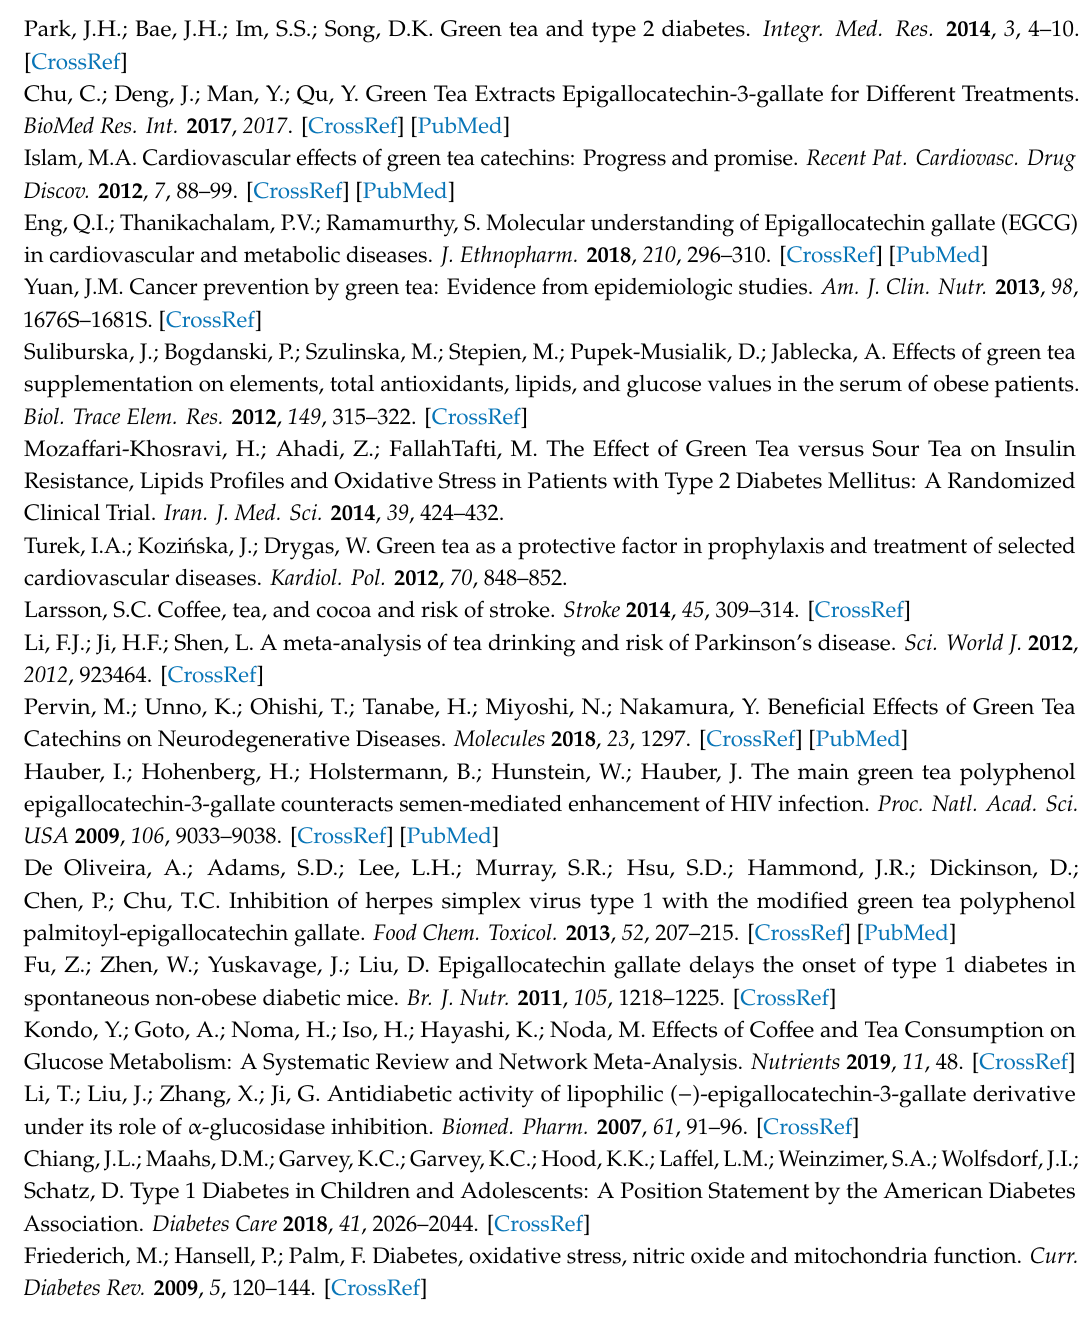
Table S1: p -values for comparisons between the study groups for all studied